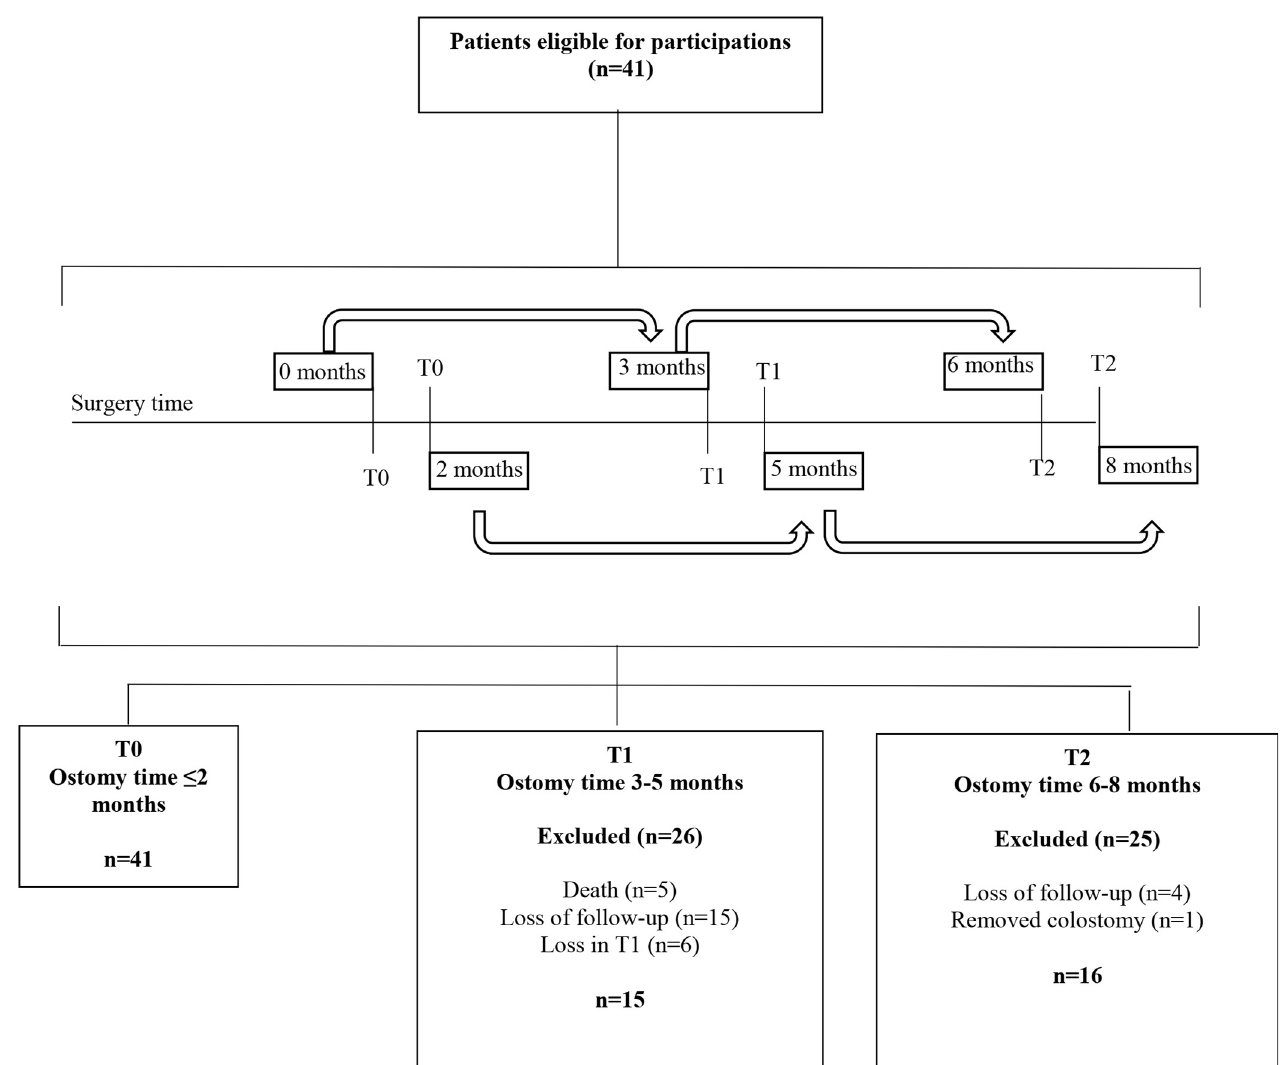
Fig 1. Diagram reporting the number of patients with ostomies due to colorectal cancer screened and recruited in this study.